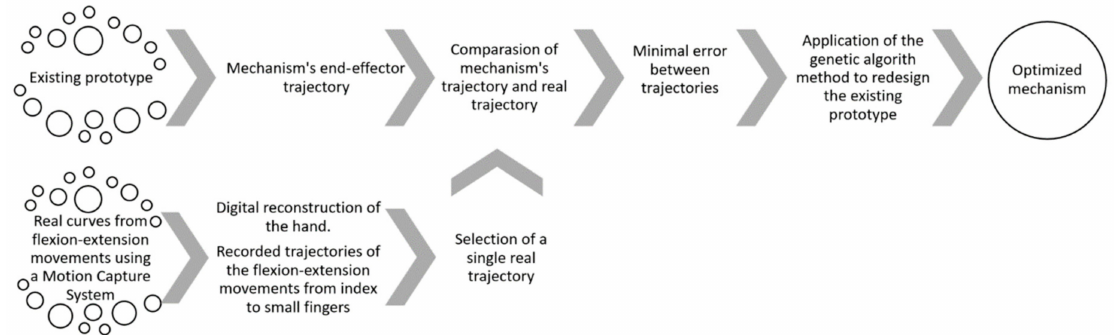
Figure 2. The block diagram for the approach.